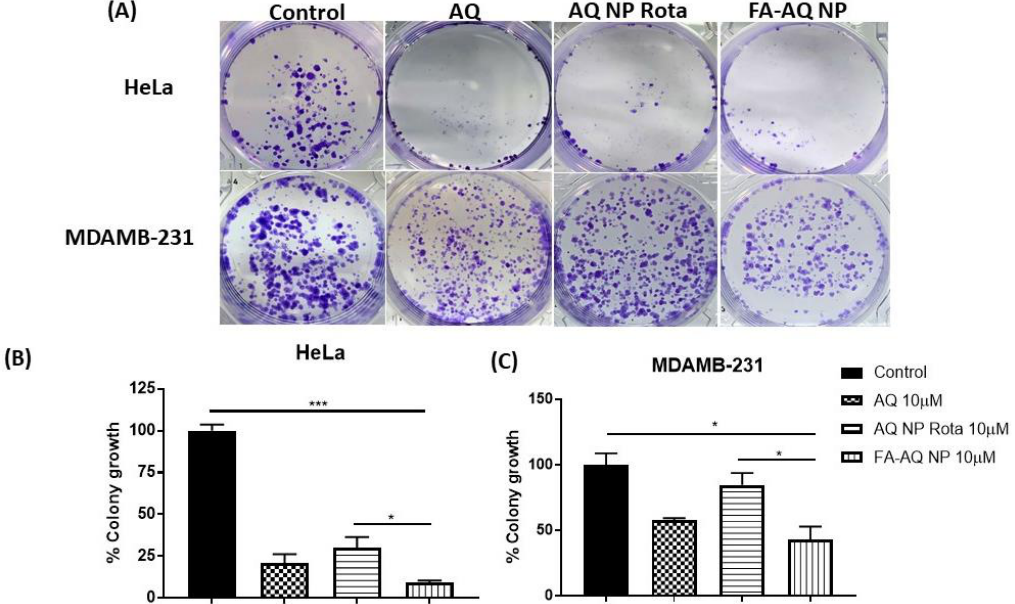
Figure 7. ( A ) Representative images showing distinct colonies after staining in HeLa and MDAMB- 231 cell lines. Three different experiments were performed. ( B , C ) Quantitative representation of clonogenic assay as % colony growth with AQ, AQ NP Rota, and FA-AQ NPs treatment as compared to control in HeLa and MDAMB-231 cell lines, respectively. Data represent mean ± SEM (n = 3). * p < 0.05 and *** p < 0.001.